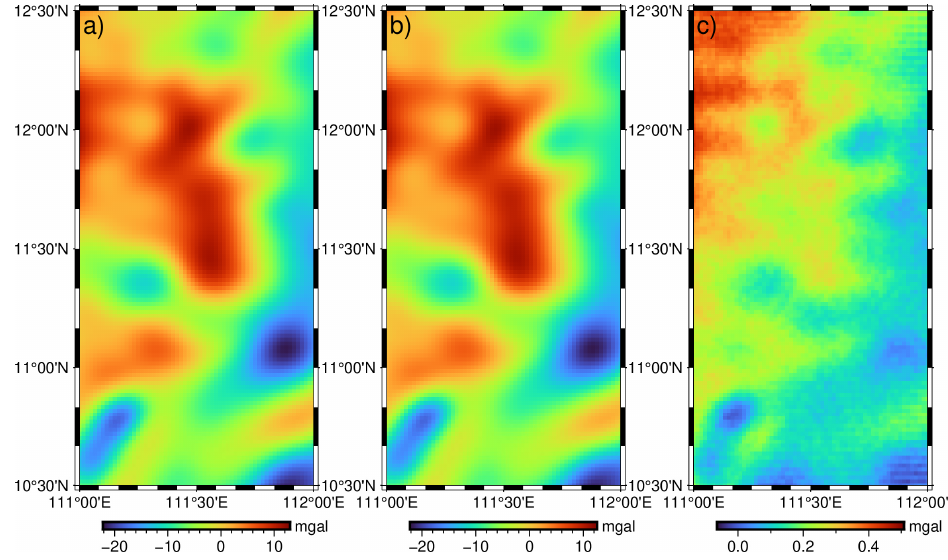
Figure 7. GA: ( a ) true value; ( b ) recovered value; ( c ) error. Table 1. Statistics on the accuracy of the recovered DV and GA.